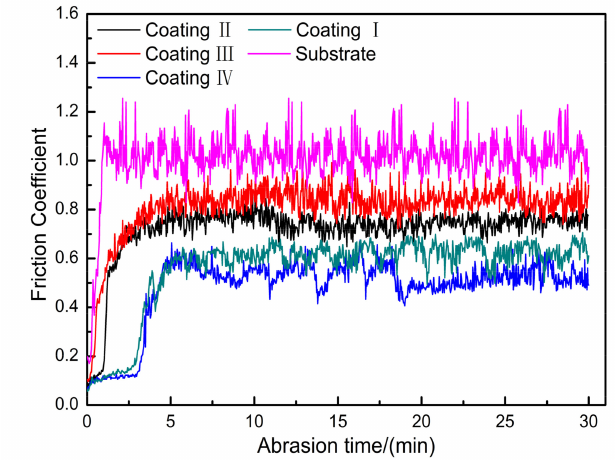
Figure 11. Friction coefficient of cladding layer with time.